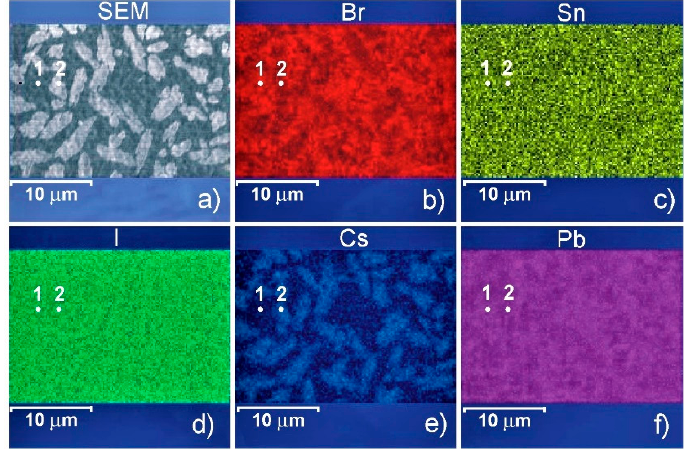
Figure 3. Surface SEM image ( a ) and mapping images of EDX analysis of 30% CsI containing